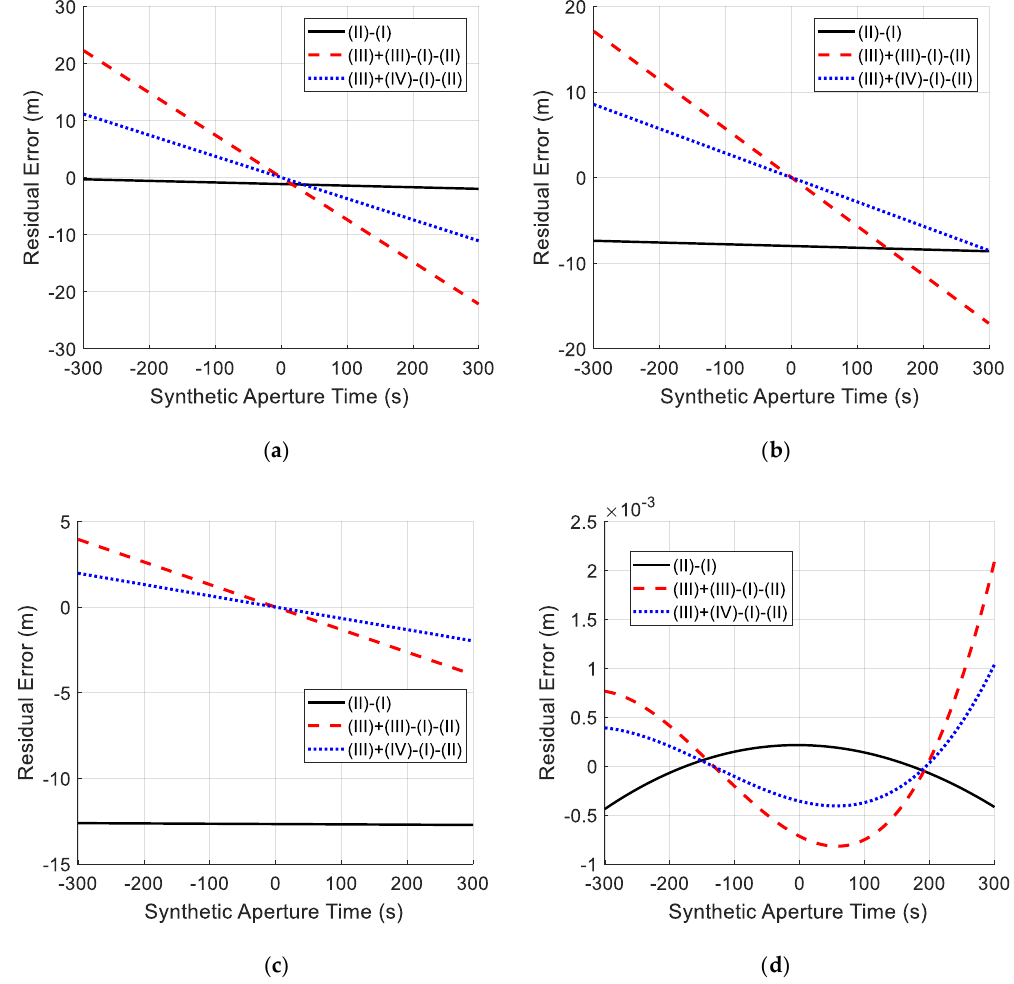
Figure 13. The range difference of (II), (III), and (IV) referred to (I) when the SAR is at (−80,0) on lunar surface and the target is at (a) (0,0) , (b) (40,0) , and (c) (80,0) on Earth’s surface. The surface and the target is at ( a ) ( 0,0 ) , ( b ) ( 40,0 ) , and ( c ) ( 80,0 ) on Earth’s surface. The synthetic aperture synthetic aperture center is calibrated to the time of closest range at 2017/10/9. Subfigure (d) center is calibrated to the time of closest range at 2017 / 10 / 9. Subfigure ( d ) indicates the detrended result indicates the detrended result of subfigure (a). of subfigure ( a